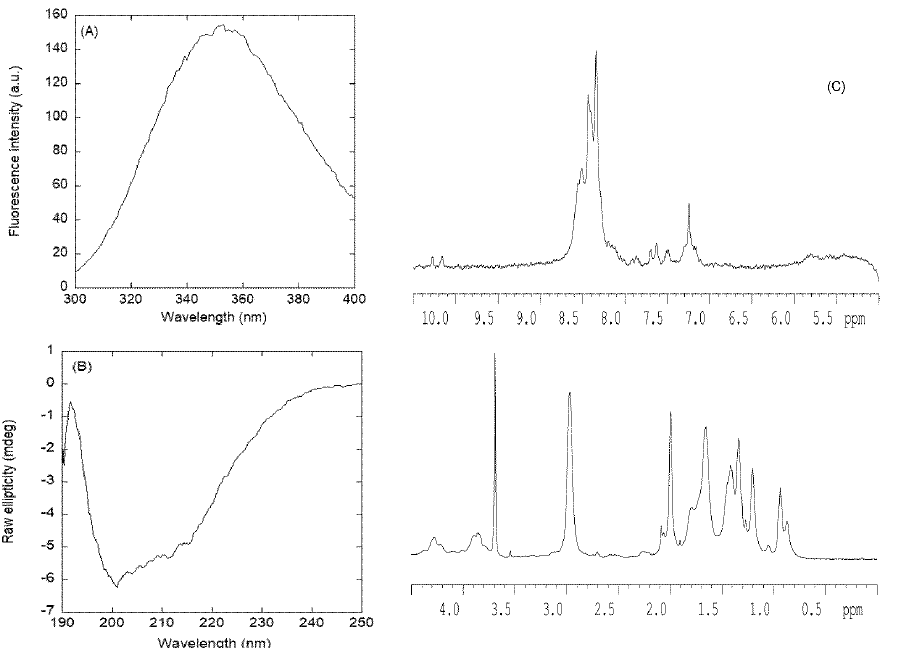
Figure 3. Conformational features of isolated NLS1-PADI4 in solution. ( A ) Fluorescence spectrum of NLS1-PADI4 in 20 mM Tris buffer (pH 7.5), 5 mM TCEP, 150 mM NaCl, and 5% glycerol at 25 °C. ( B ) Far-UV CD spectrum of NLS1-PADI4 at 25 °C in sodium phosphate buffer (50 mM, pH 7.5). ( C ) 1D- 1 H-NMR spectrum of isolated NLS1-PADI4 at 10 °C and pH 7.0 (100 mM, sodium phosphate buffer).